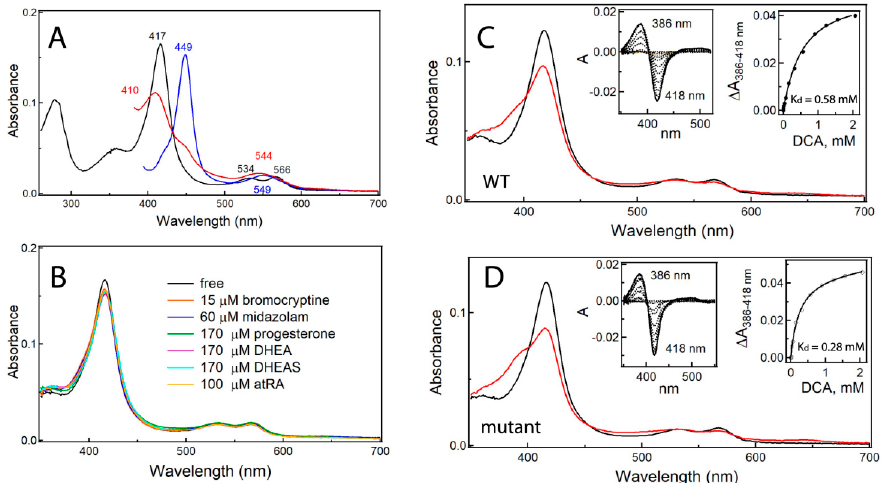
Figure 1. ( A ) Absorbance spectra of 1.5 μ M ferric (black), ferrous (red), and ferrous-CO bound (blue) CYP3A7mut. Absorbance maxima are indicated. Spectra were measured in 0.1 mM potassium phosphate buffer pH 7.4, supplemented with 20% glycerol and 1 mM dithiothreitol, and were similar to those of WT CYP3A7. ( B ) Lack of changes in the Soret band of CYP3A7 in the presence of substrates at saturating concentrations. ( C , D ) Spectral changes induced by DCA in the WT and mutant CYP3A7, respectively. Black and red spectra were recorded before and after equilibrium titrations, with the final DCA concentration of 2.1 mM. Left insets are difference spectra recorded after each DCA addition. Right insets are titration plots with hyperbolic fits, from which the dissociation constants (K d ) for DCA were